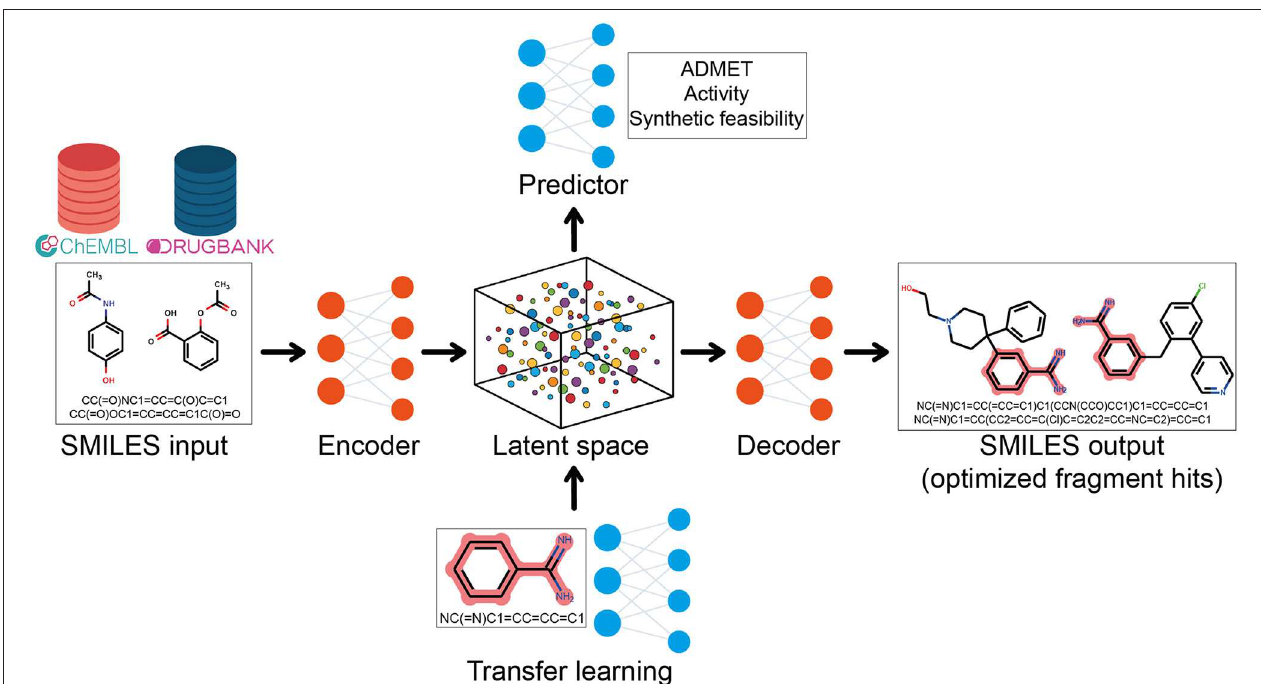
FIGURE 7 | Representation of the integrative approach of generative and predictive deep learning models and transfer learning for fragment-to-lead